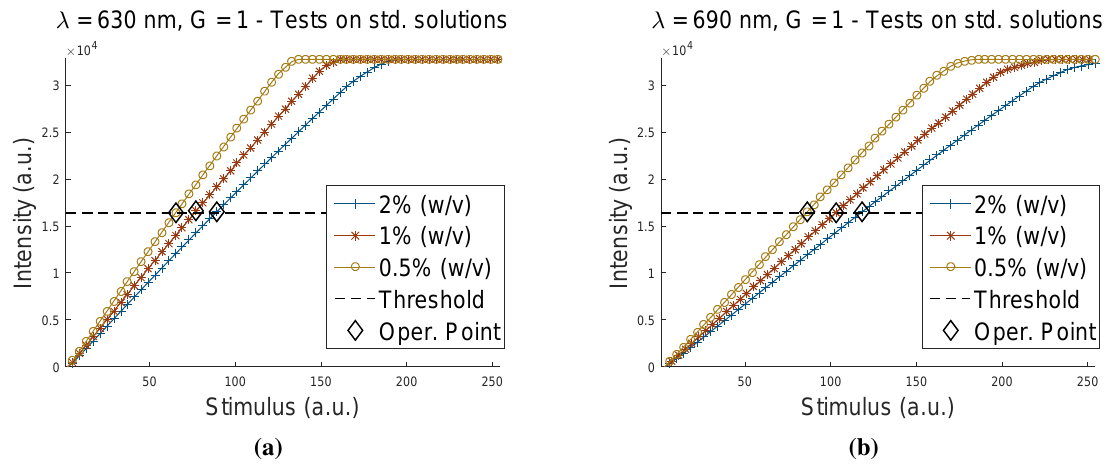
Figure 5. Output Intensity vs. Stimulus with the Gain parameter G = 1 for acquisitions on aqueous solutions of blue dye at different concentrations: ( a ) channel at λ = 630 nm; and ( b ) channel at λ = 690